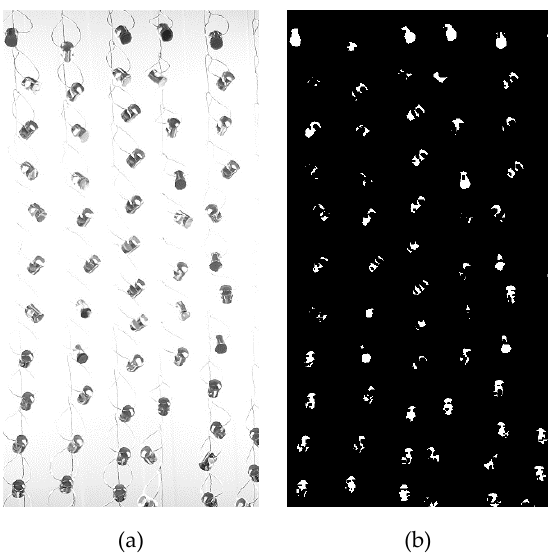
Figure 10. ( a ) Original image acquired with backlighting; ( b ) image of Figure 10a after thresholding showing that some items portions are mistakenly assigned to the